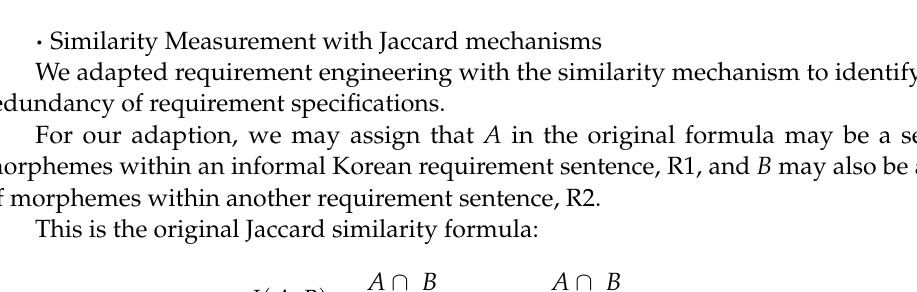
Figure 9. The similar identification with the Jaccard similarity and theta-role.